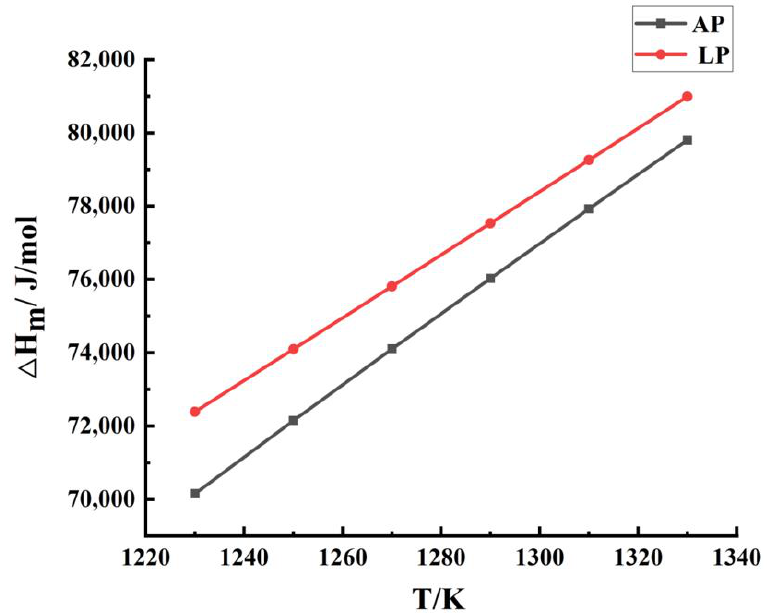
Figure 3. Molar reaction enthalpy of methane decomposition at different temperatures.